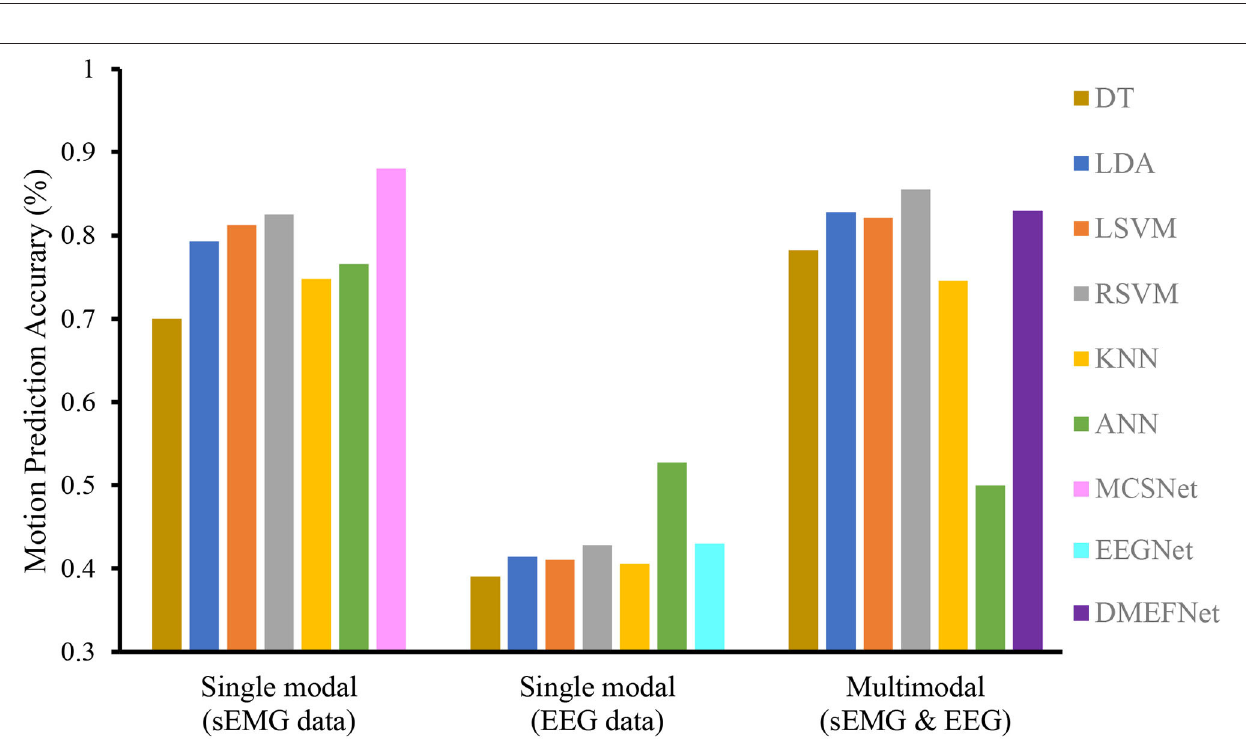
FIGURE 5 | Within-subject movement prediction performance, the input of six traditional machine learning-based movement prediction models are sEMG and EEG multimodal data. Four-fold cross-validation is used to avoid the phenomenon of model overfitting, averaged over all folds and all subjects. Error bars denote two standard errors of the